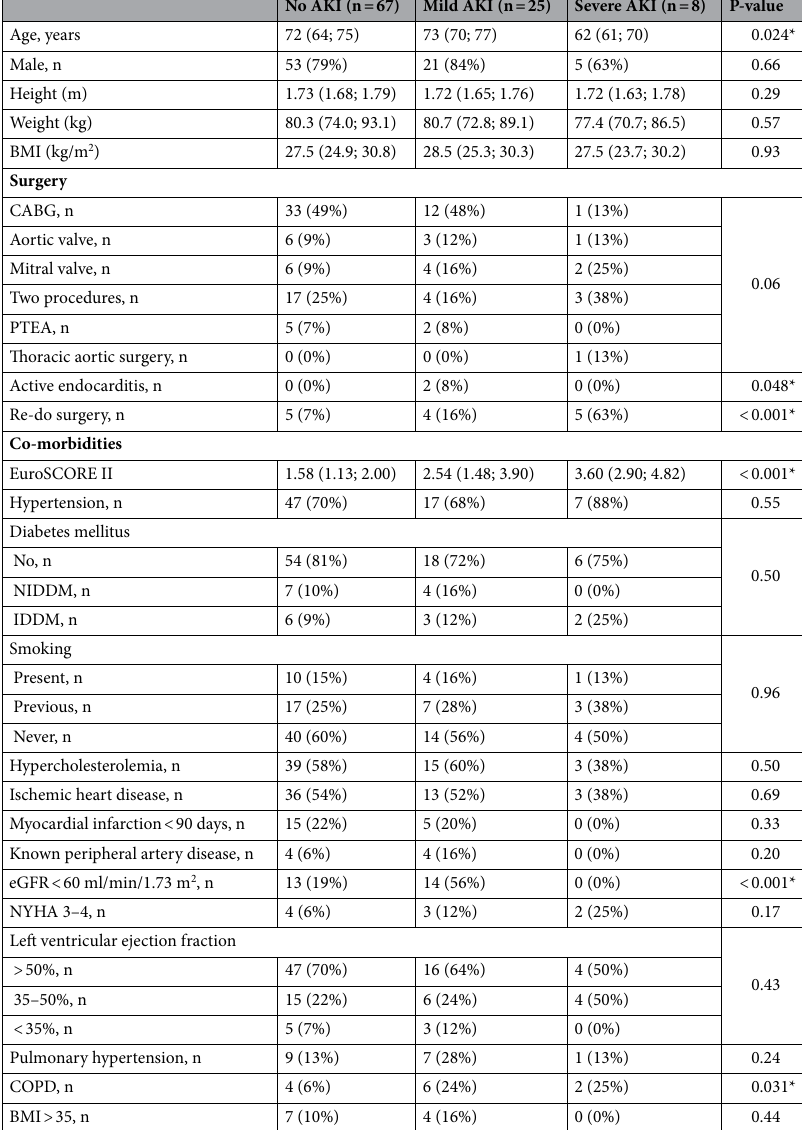
Table 1. Baseline patient characteristics. Median and interquartile range (IQR) or number (n) and percent. P-values refer to difference between any of two of groups no AKI, mild AKI and severe AKI. No AKI, mild AKI and severe AKI refer to patients who did not develop AKI, developed mild AKI (KDIGO grade 1) or developed severe AKI (KDIGO grades 2 + 3) within the first 4 postoperative days. * indicates statistically significant difference (P < 0.05). AKI acute kidney injury, BMI body mass index, CABG coronary artery bypass grafting, COPD chronic obstructive pulmonary disease, eGFR estimated glomerular filtration rate,